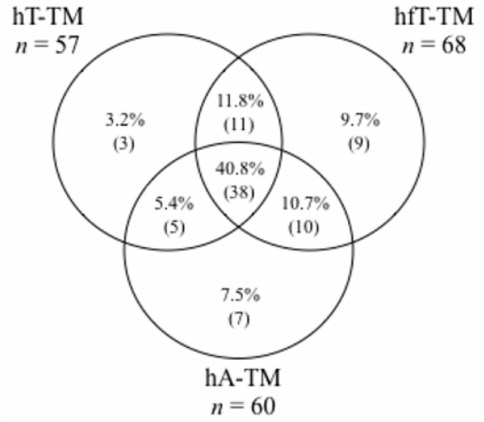
Figure 1. Distribution of the patterns of biochemical hyperandrogenism based by LC-MS/MS androgens quantification in PCOS patients. hT-TM: high testosterone by LC-MS/MS. hfT-TM: high free testosterone by LC-MS/MS. hA-TM: high androstenedione by LC-MS/MS.